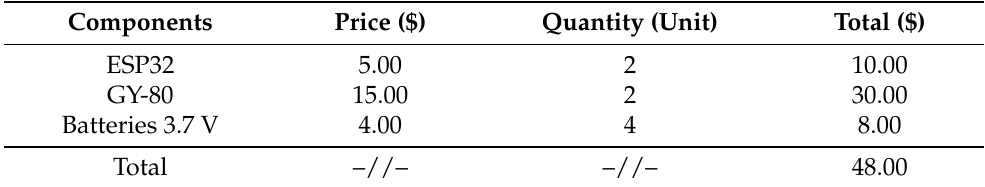
Table 1. Hardware